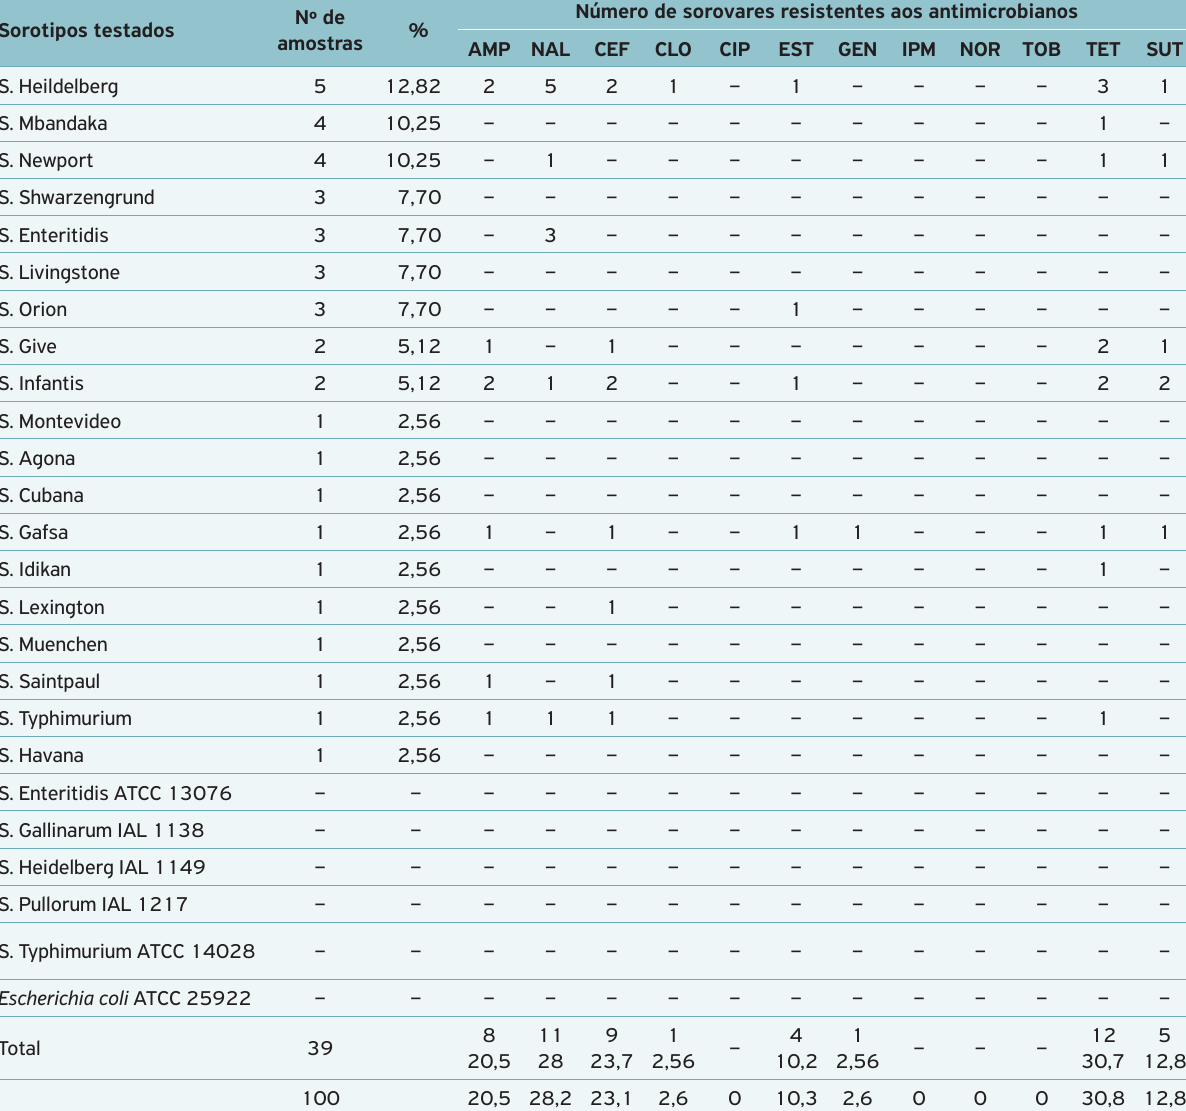
de 2011 no Oeste do